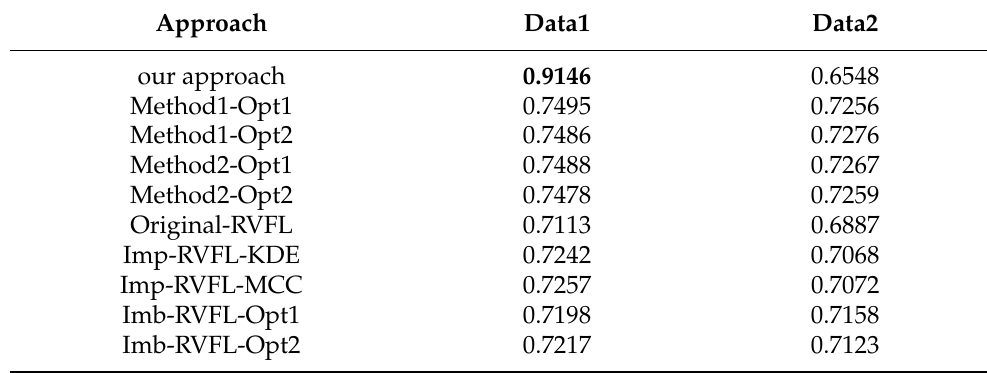
Table 18. Validation of our proposed method with the proposed methods by [89] in terms of G- mean